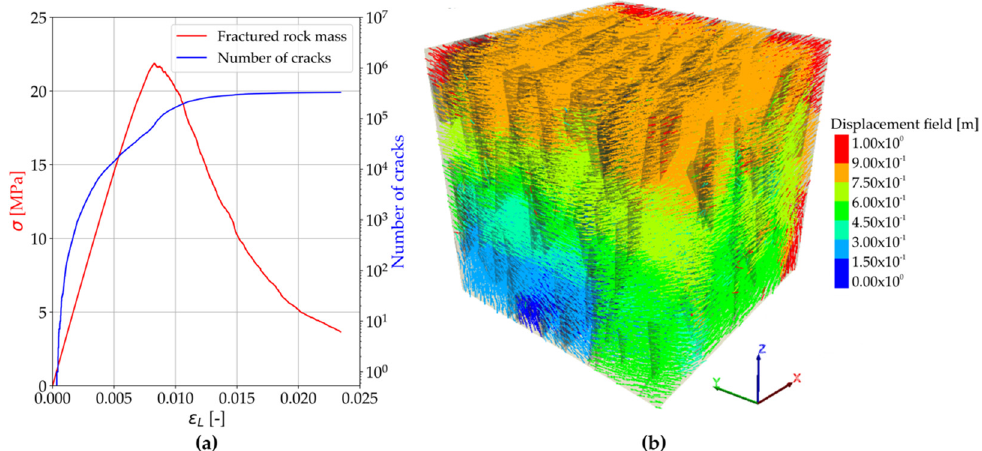
Table 7. Results of the rock mass properties using the LS ‐ SRM model in combination with the DFN model.